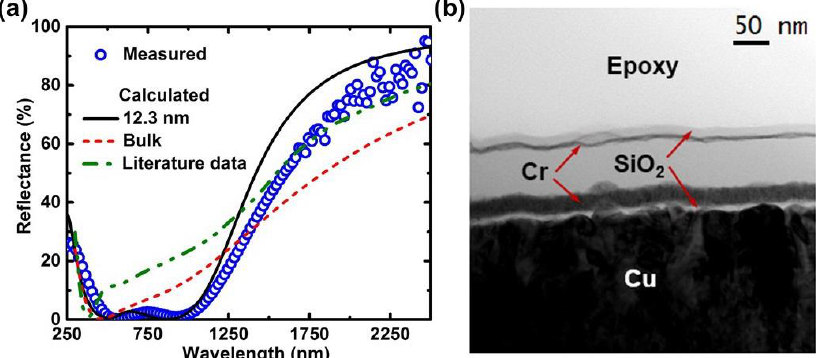
Figure 4. ( a ) Reflectance spectra of the deposited sample and design, ( b ) cross-sectional image of the fabricated sample.